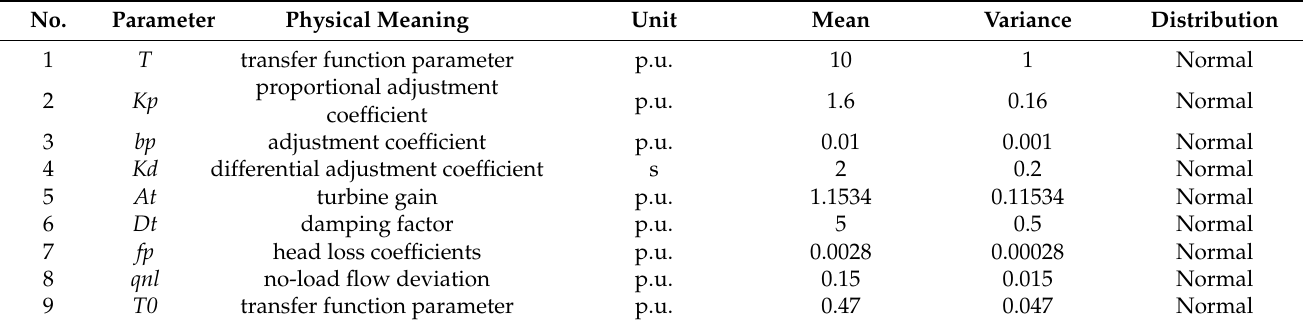
Table A2. The basic characteristics of the parameters of the WSH hybrid